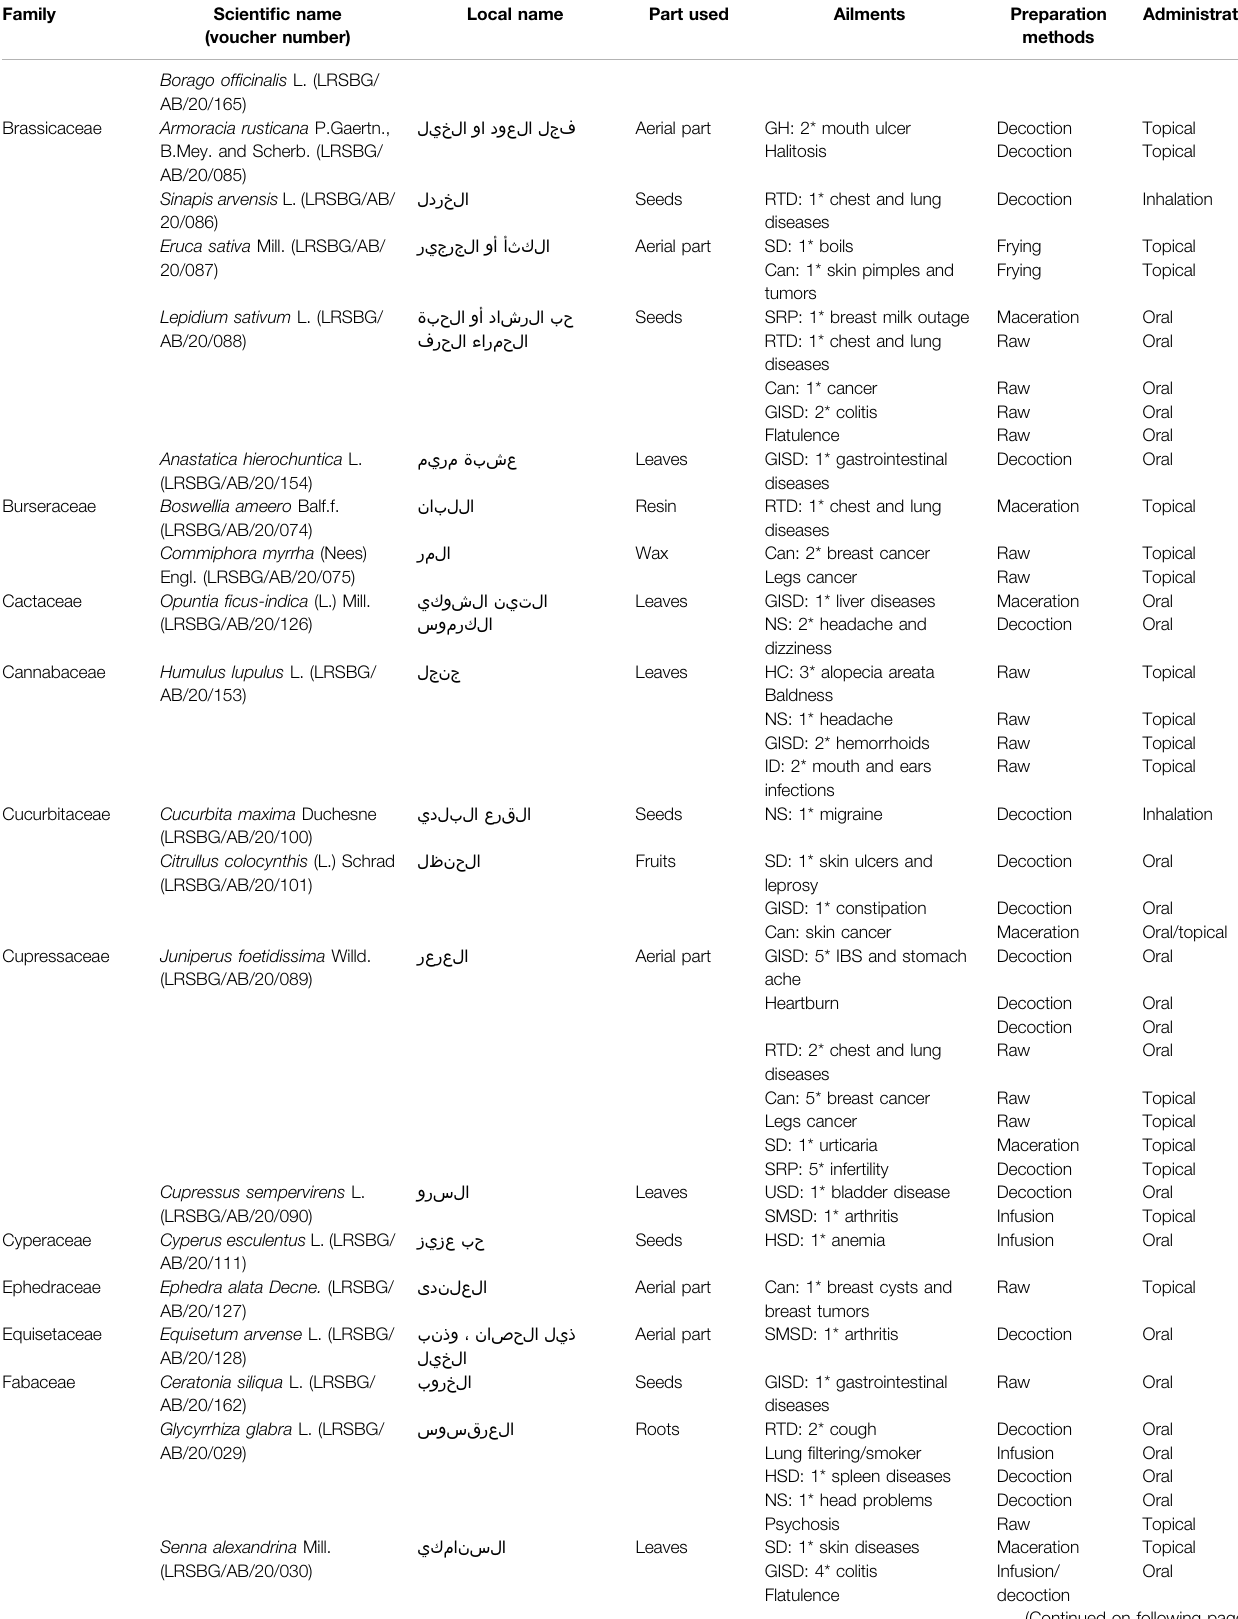
TABLE 7 | ( Continued ) List of medicinal plants used by traditional healers in the study areas.